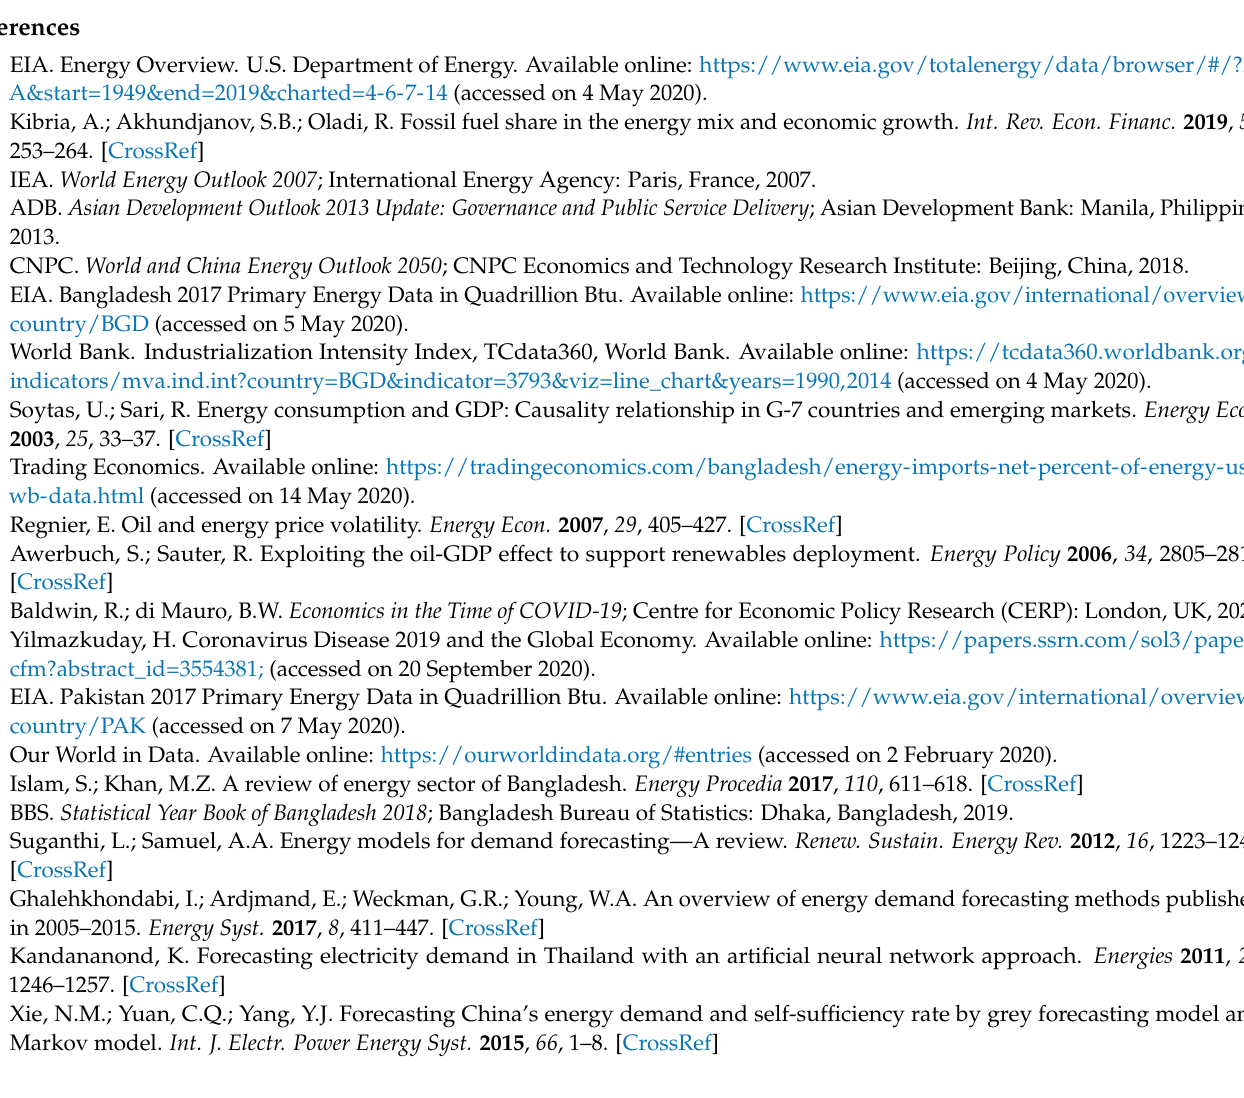
Figure A2. Forecast total energy demand for model 1 and upper and lower confidence limit at 95% (model